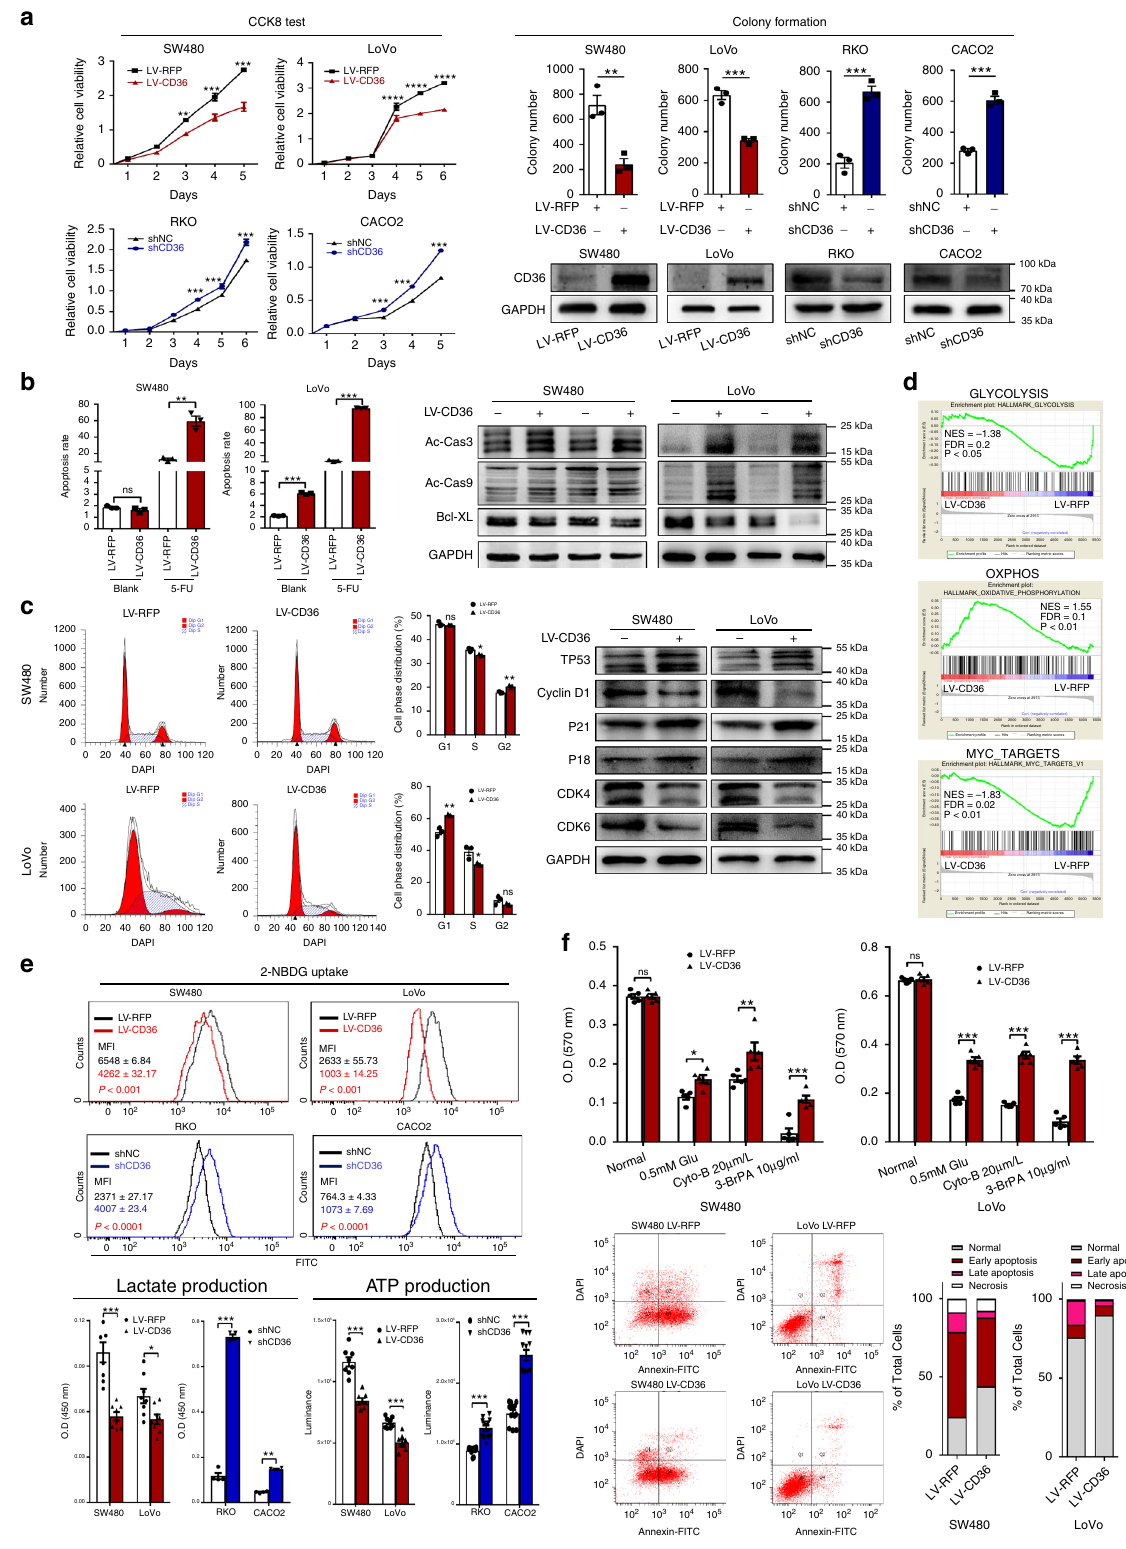
Fig. 2 CD36 plays anti-carcinogenic roles via repressing glycolysis. a CCK8 assays and colony formation assays, transfection ef fi ciency was determined by western blot. b Cell apoptosis under normal conditions and 5-Fu treatment and western blots of apoptosis markers. c Cell cycle analysis and western blots of cell cycle markers. d Gene-set enrichment analysis (GSEA) of the protein pro fi les between SW480 LV-CD36 and SW480 LV-RFP cell lines. e 2-NBDG uptake, lactate production and ATP production. f Cell viability was measured by MTT assays (up) under different culture conditions. Cell apoptosis of SW480 and LoVo cells (LV-RFP vs. LV-CD36) with low glucose conditions (down). Each experiment was performed at least triplicate and results are presented as mean ± SEM. Student ’ s t -test, one-way ANOVA or two-way ANOVA was used to analyze the data (* P < .05, ** P < .01, *** P < .001, **** P < .0001). Source data are provided as a Source Data fi